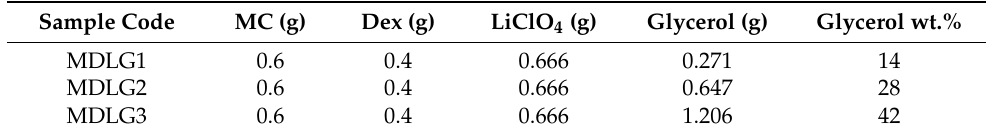
Table 5. The identification and composition for the MC-Dex-LiClO 4 –glycerol systems. Sample